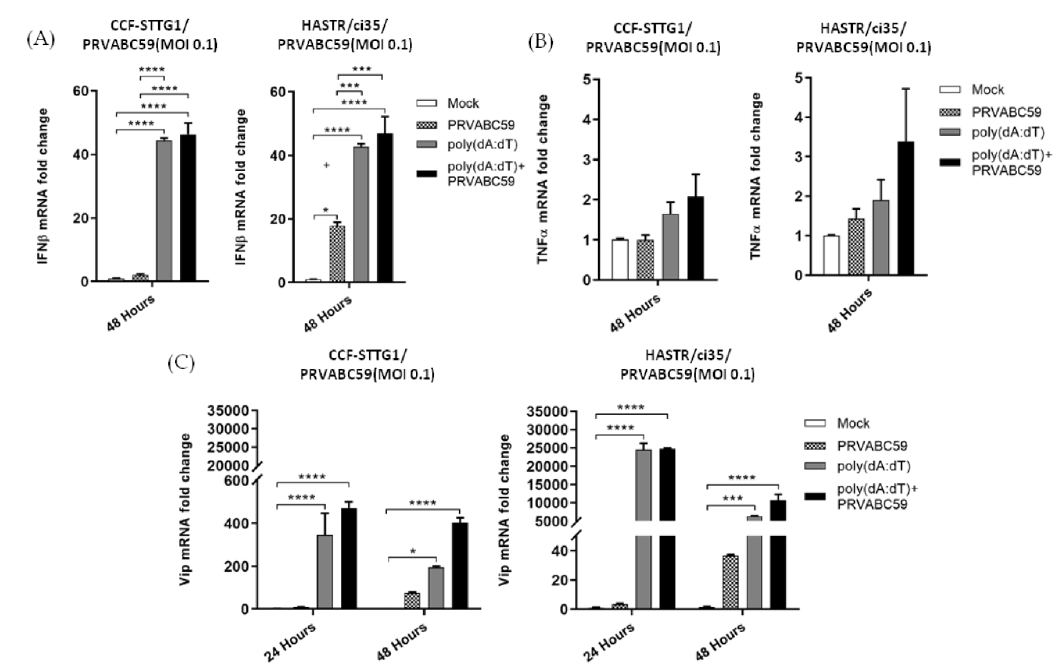
Figure 8. Expression of antiviral and inflammatory genes in poly(dA:dT) pre-stimulated, and ZIKV-infected CCF-STTG1 and HASTR/ci35 cells. Antiviral and proinflammatory gene expres- sion following stimulation with poly(dA:dT) following PRVABC59 or mock infection. Subconfluent ZIKV-resistant CCF-STTG1 and -susceptible HASTR/ci35 cells were transfected with 1 µ g/mL poly (dA:dT) 18 h prior to infection with PRVABC59 strain. Cell lysates were collected at either 48-hour ( A , B ) or 24- and 48-h timepoints ( C ) to assess relative mRNA expression of major antiviral (IFN- β and viperin) and inflammatory (TNF α ) genes. Both astrocyte cell types showed similar patterns in expression of the above-mentioned genes. Data were normalised to the 36b housekeeping gene and expressed as a fold change relative to mock-infected control (data are shown as means ± SEM, n = 3). *, *** and **** demonstrate significant differences between biological conditions at the level of p < 0.05, p < 0.001 and p < 0.0001,